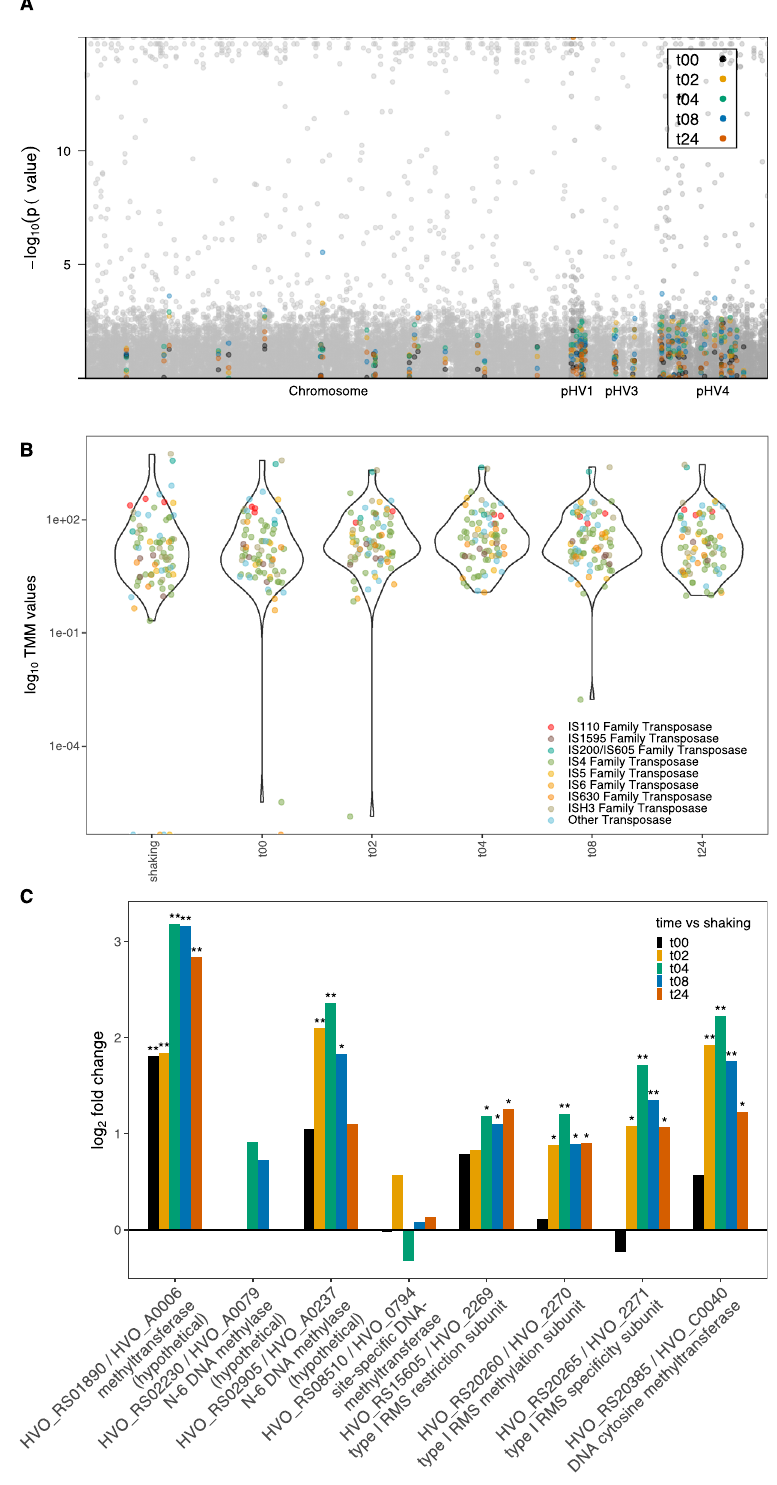
Figure 6. ( A ) Manhattan plot with chromosome number on the x-axis and − log10 p value of differential expression for planktonic cells vs plated timepoints on the y-axis, all genes are plotted in grey and genes for insertion sequences are highlighted by color according to the key; ( B ) Violin plot showing log 10 of average normalized expression values for each treatment on the y-axis; ( C ) Bar plot depiction of differential expression compared to planktonic state for restriction modification system genes; gene id on the x-axis and log 2 fold change on the y-axis, * p value < 0.05 and ** p value <